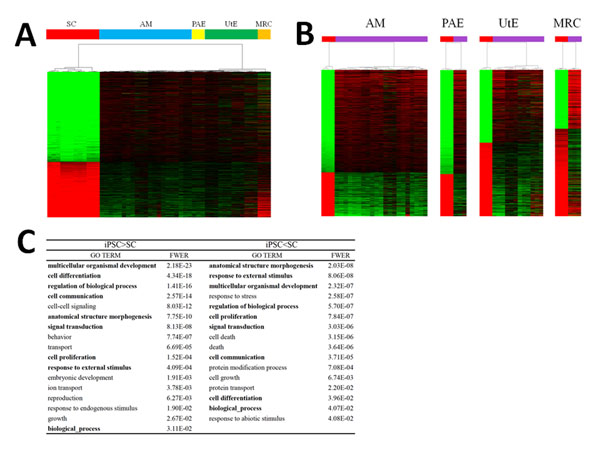
Gene expression signature (A) Heat map of 2,502 genes in the hiPSCs and parental cells. Cell types are indicated by colored bars. (B) Heat maps for the MRC, AM, UtE, and PAE hiPSCs and their corresponding parental cells. The hiPSCs and the parental SCs are discriminated by colored bars (red, SCs; purple, hiPSCs). (C) GO terms in the Biological Process, with the significance probabilities for the genes with higher and lower levels of expression. GO terms were summarized into 33 terms, as a macroscopic view, and the overlapped terms in the higher and lower expression classes are indicated by bold characters. See also additional file 6.